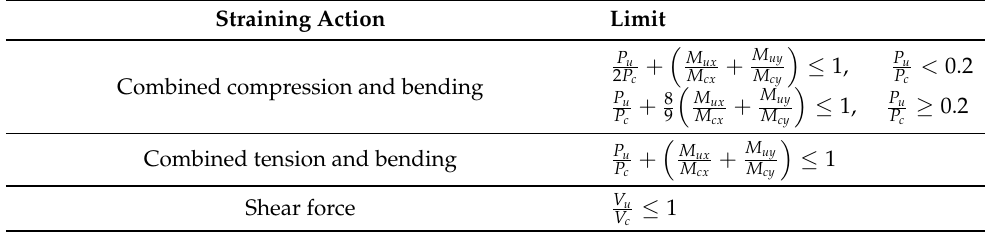
Table 2. Strength constraints.